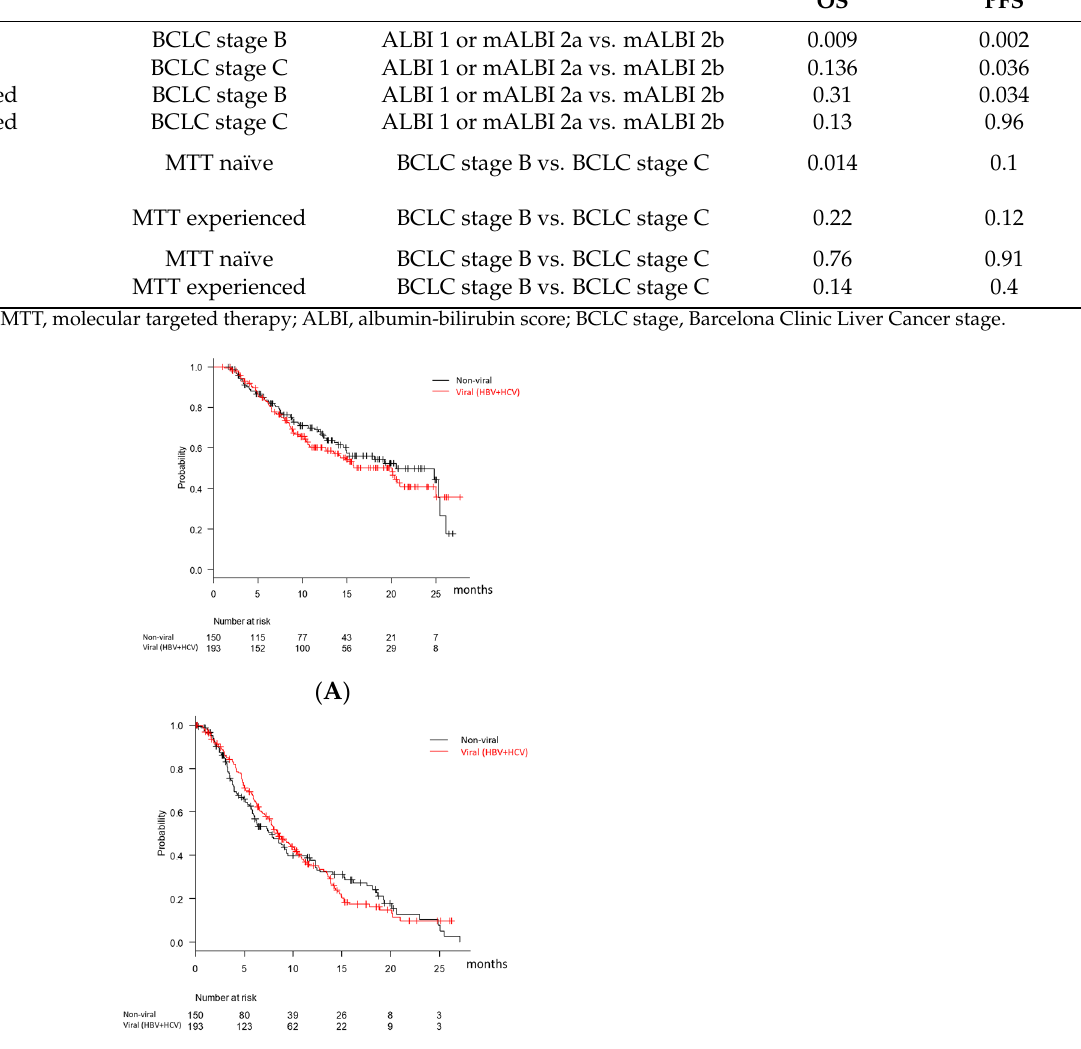
Table 4. The statistical comparisons according to BCLC stage, MTT experience, and ALBI grade.